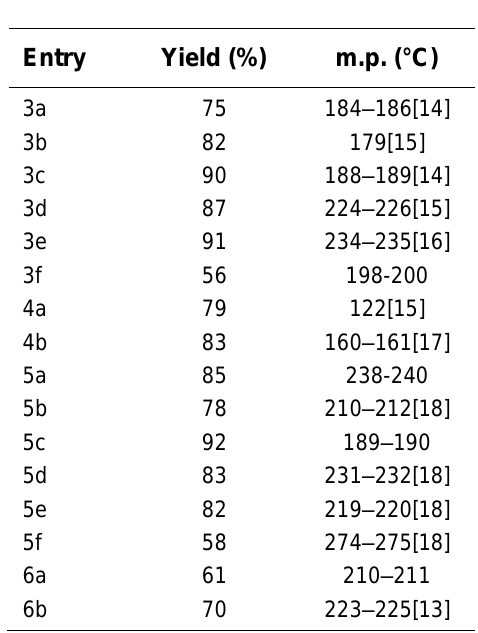
Yields and Melting Points of Isonicotinoyl Hydrazones and